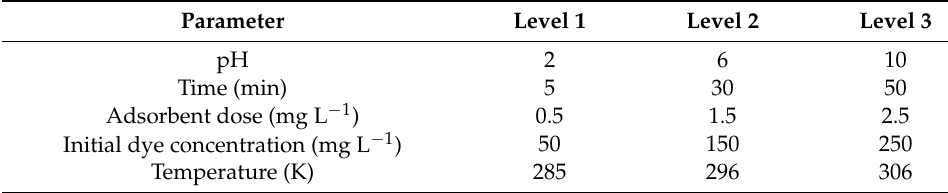
Table 1. The controllable parameters and their